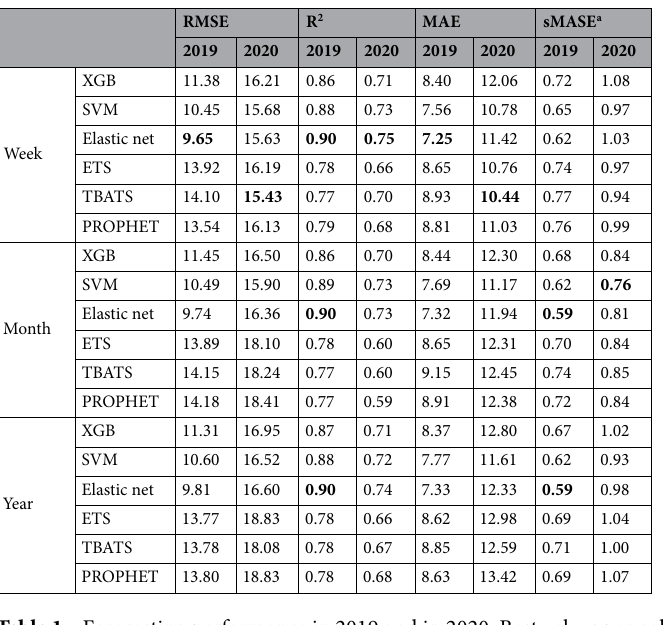
Table 1. Forecasting performance in 2019 and in 2020. Best values per column are in boldface. RMSE Root- mean-squared-error, MAE Mean absolute error, sMASE Seasonal mean absolute scaled error. a The naïve seasonal forecasts were based on the number of admissions 14, 35 and 364 days before the predicted day for the weekly, monthly and yearly models, respectively.